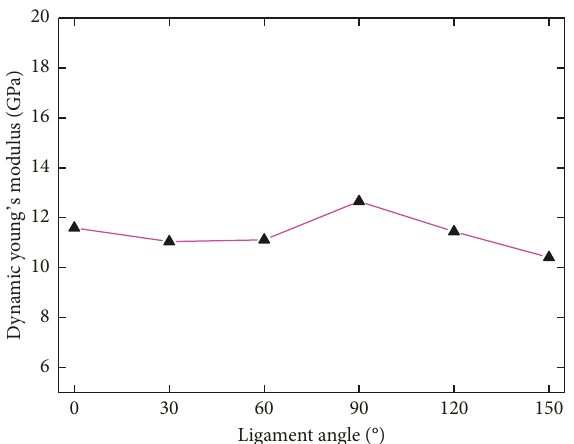
Figure 11: Influence of the ligament angle on the dynamic Young’s modulus of specimens with a constant flaw angle of 0 ° .